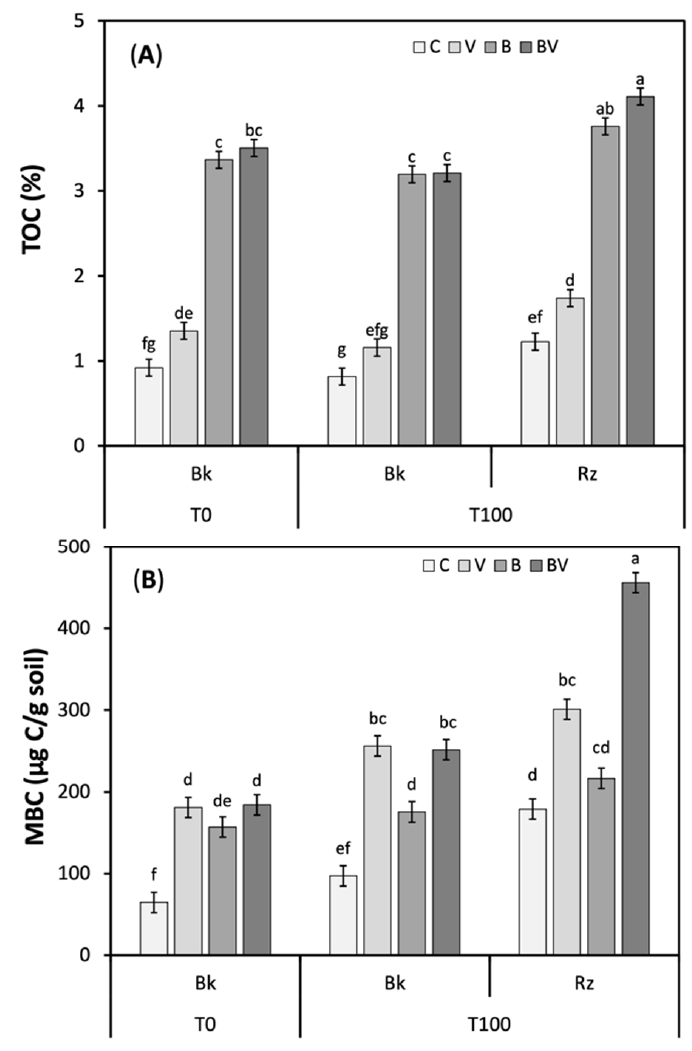
Figure 1. Total organic C ( A ) and dissolved organic C ( B ) in the bulk (Bk) and rhizosphere (Rz) soils amended with different fertilisers at the start (T0) and end (T100) of tomato cultivation. CTR—control; V—vermiwash; B—biochar; BV—biochar together with vermiwash. Bars represent SE of the interaction sample time × fertiliser × soil region. Different letters indicate significant differences among treatments ( p < 0.05; Tukey’s test).